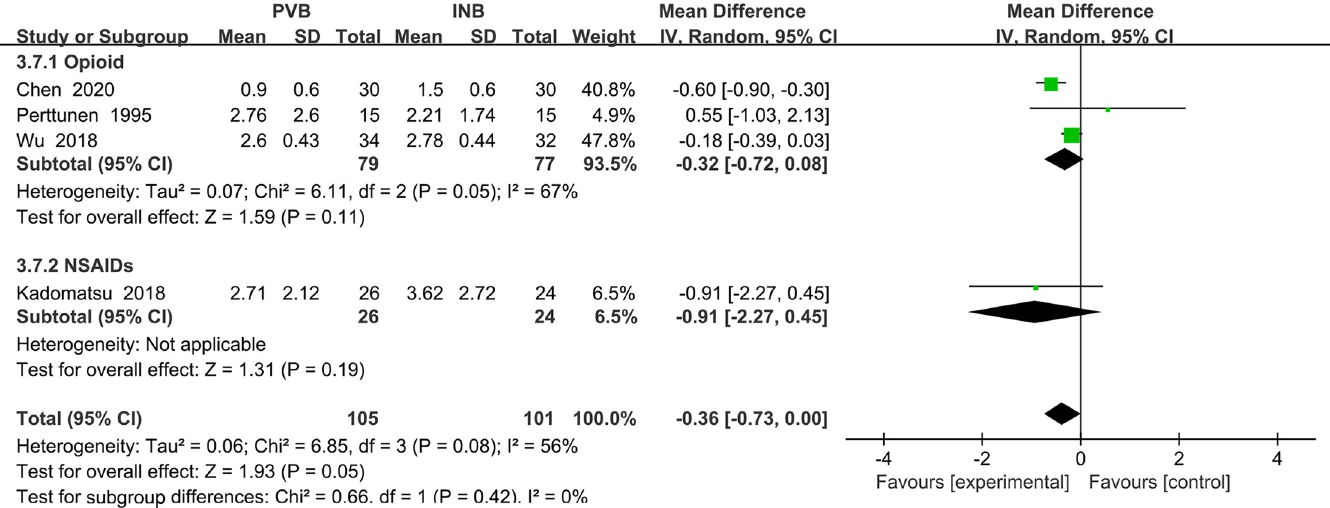
PLOS ONE | https://doi.org/10.1371/journal.pone.0237363 October 5,